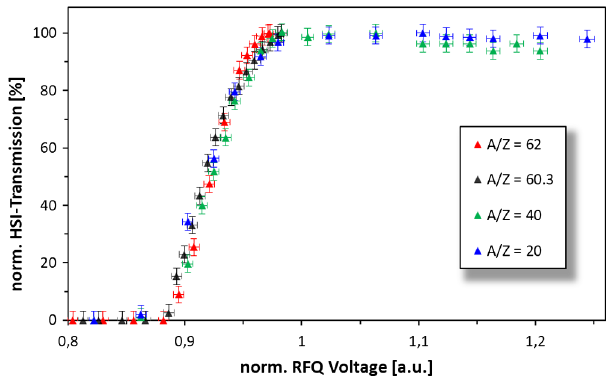
FIG. 3. Measured normalized beam transmission at HSI for Xe, Ta, and Ar beams as a function of norm. RFQ voltage, RFQ working point is set to norm. RFQ voltage ¼ 1